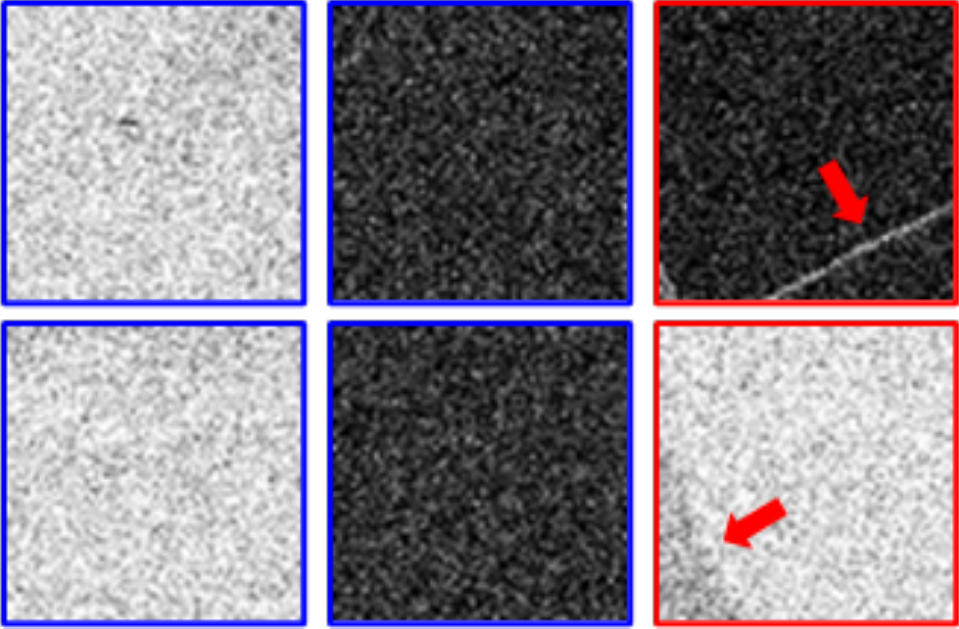
Figure 5. Noise patches extracted from the averaged output of four noisy LR images using RealSR [4]. The blue boxes indicate normal noise patches, and red boxes indicate falsely detected noise patches, with the arrows showing the falsely detected